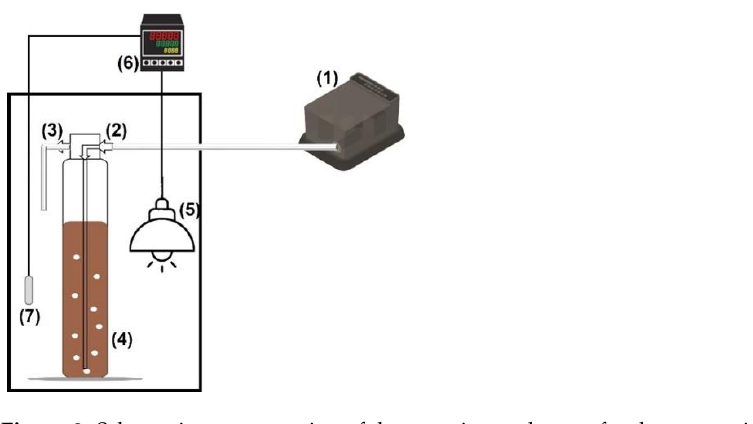
Figure 2. Schematic representation of the experimental setup for the ammonia stripping experiments: 1 — air pump, 2 — air entrance, 3 — air exit, 4 — bubble column reactor containing the wastewater, 5 — infrared lamp, 6 — set point controller, and 7 — temperature probe.